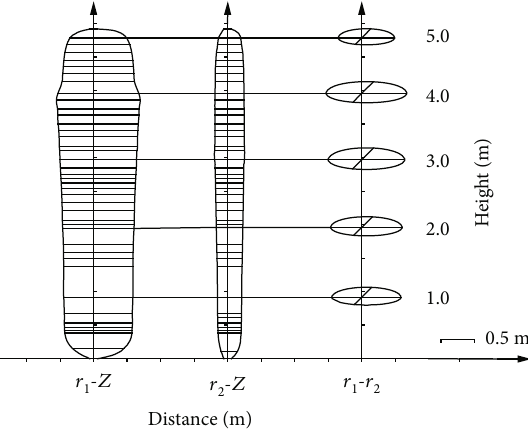
Figure 8: 7-09# hole section (drilling for hydraulic fl ushing).